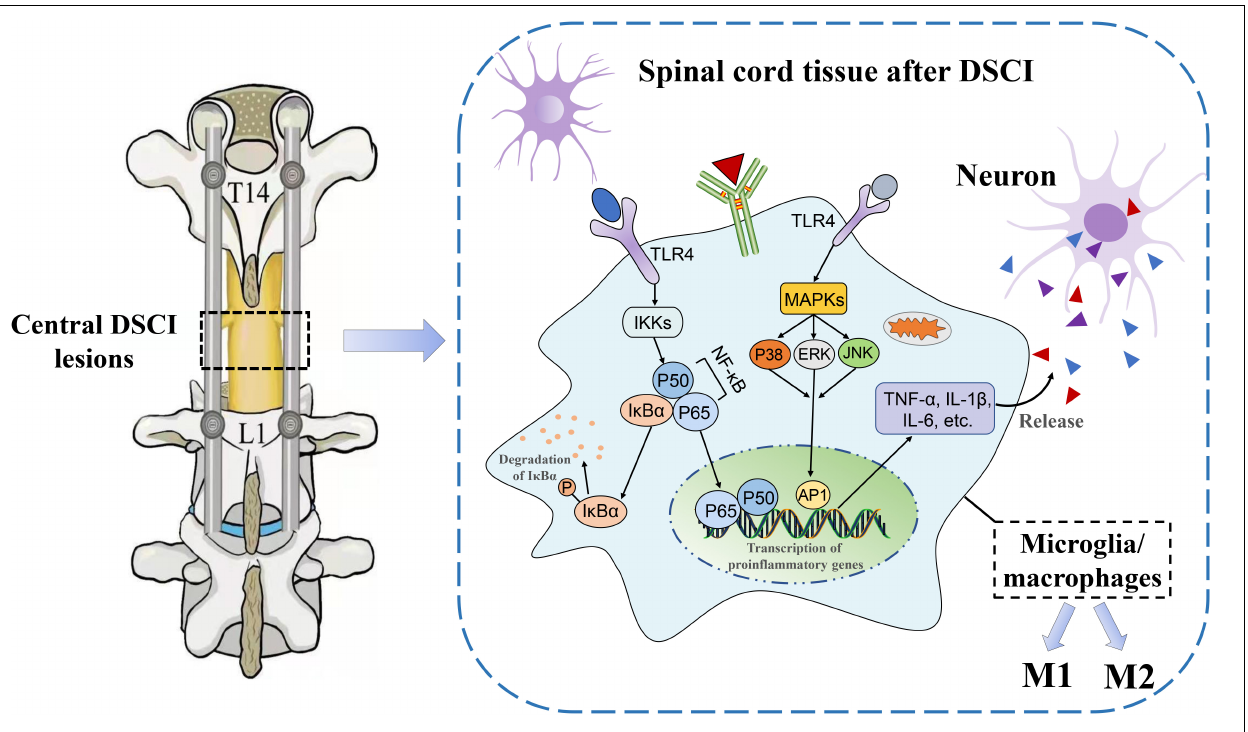
FIGURE 8 | The underlying mechanisms of neuroinflammatory mechanisms in the spinal cord tissues after DSCI. In the DSCI microenvironment, microglia/macrophages were activated and polarized into proinflammatory M1 phenotype and anti-inflammatory M2 phenotype. The TLR4 pathway is activated after DSCI and promotes inflammatory response. On the one hand, TLR4 phosphorylates I κ B α through the IKKs, rendering the NF- κ B complex dimer (mostly p65/p50 dimers) free to translocate to the nucleus. On the other hand, the MAPK pathway, including P38 MAPK, JNK, and ERK, is phosphorylated by TLR4 during the inflammatory response, thereby activating activator protein (AP)-1. Nuclear NF- κ B and AP-1 promote transcription of proinflammatory genes such as TNF- α , IL-1 β , and IL-6 to exacerbate the neuroinflammatory